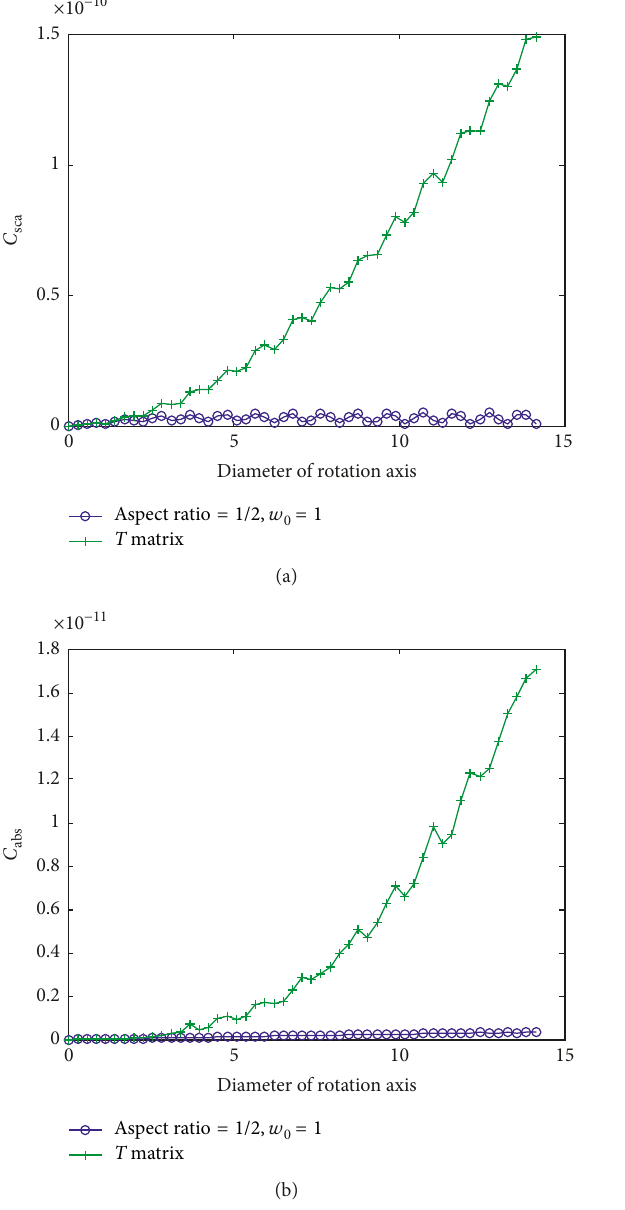
Figure 7: Scattering and absorbing cross sections of red clay particles (aspect ratio